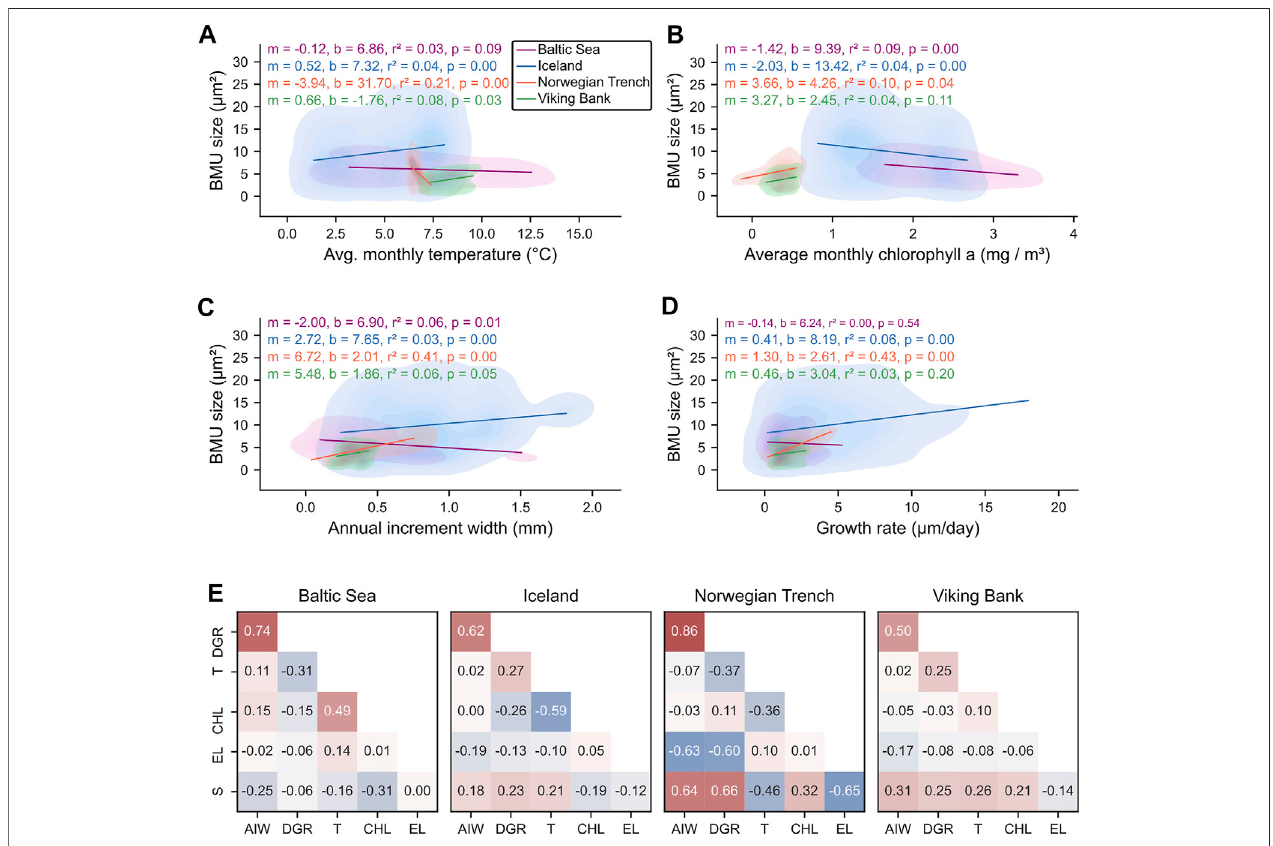
FIGURE 8 | Correlation analysis between Arctica islandica hinge plate BMU sizes, shell growth rates, and environmental records. BMU size plotted against (A) averagemonthlytemperature, (B) averagemonthlychlorophyllaconcentration (C) annualincrementwidthand (D) reconstructeddailygrowthrateateachstudylocality. Shaded areas represent the density of individual data points, and lines represent linear models. Model parameters are annotated in the plots. (E) Pearson correlation matricesofBMUsize (S)and elongation (EL),environmentalvariablesand shell growth parametersforeach locality. DGR: dailygrowth rate;AIW: annual increment width; T: temperature; CHL: chlorophyll